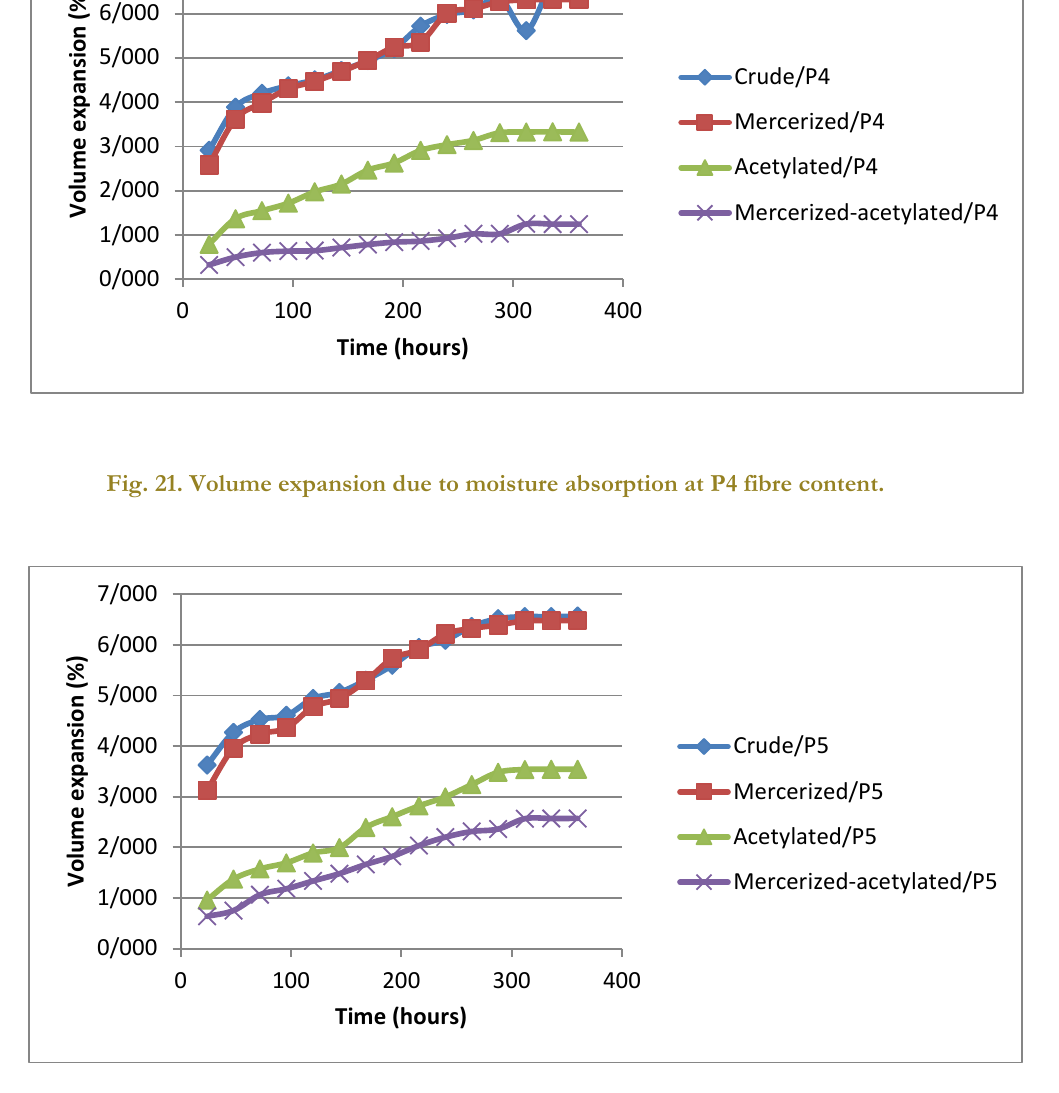
Fig. 22. Volume expansion due to moisture absorption at P5 fibre